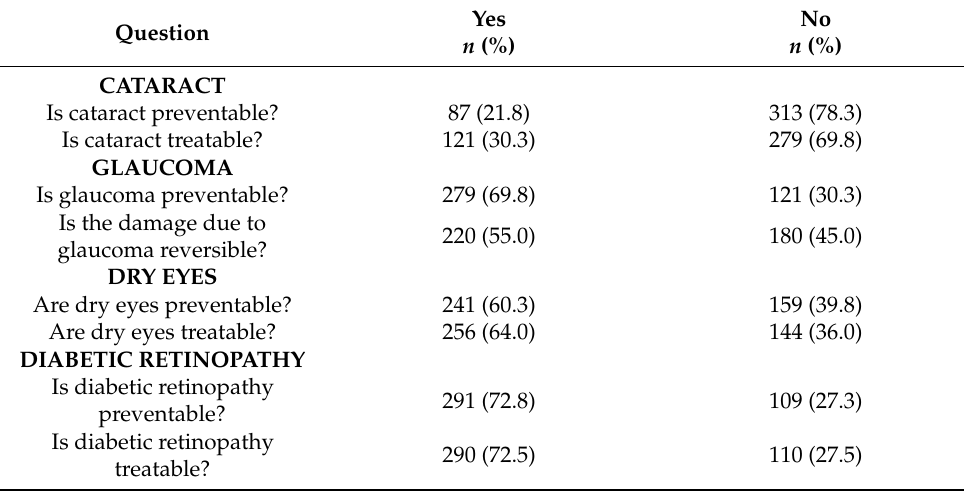
Table 3. Awareness of the treatment and prevention of various eye